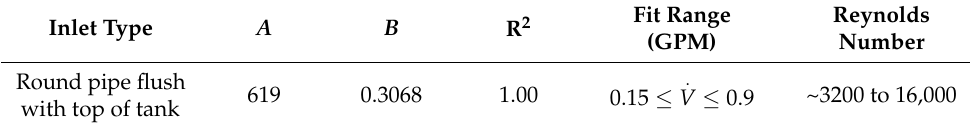
Table 1. Inlet fitting parameters, residual’s squared, minimum, and maximum flow fit.